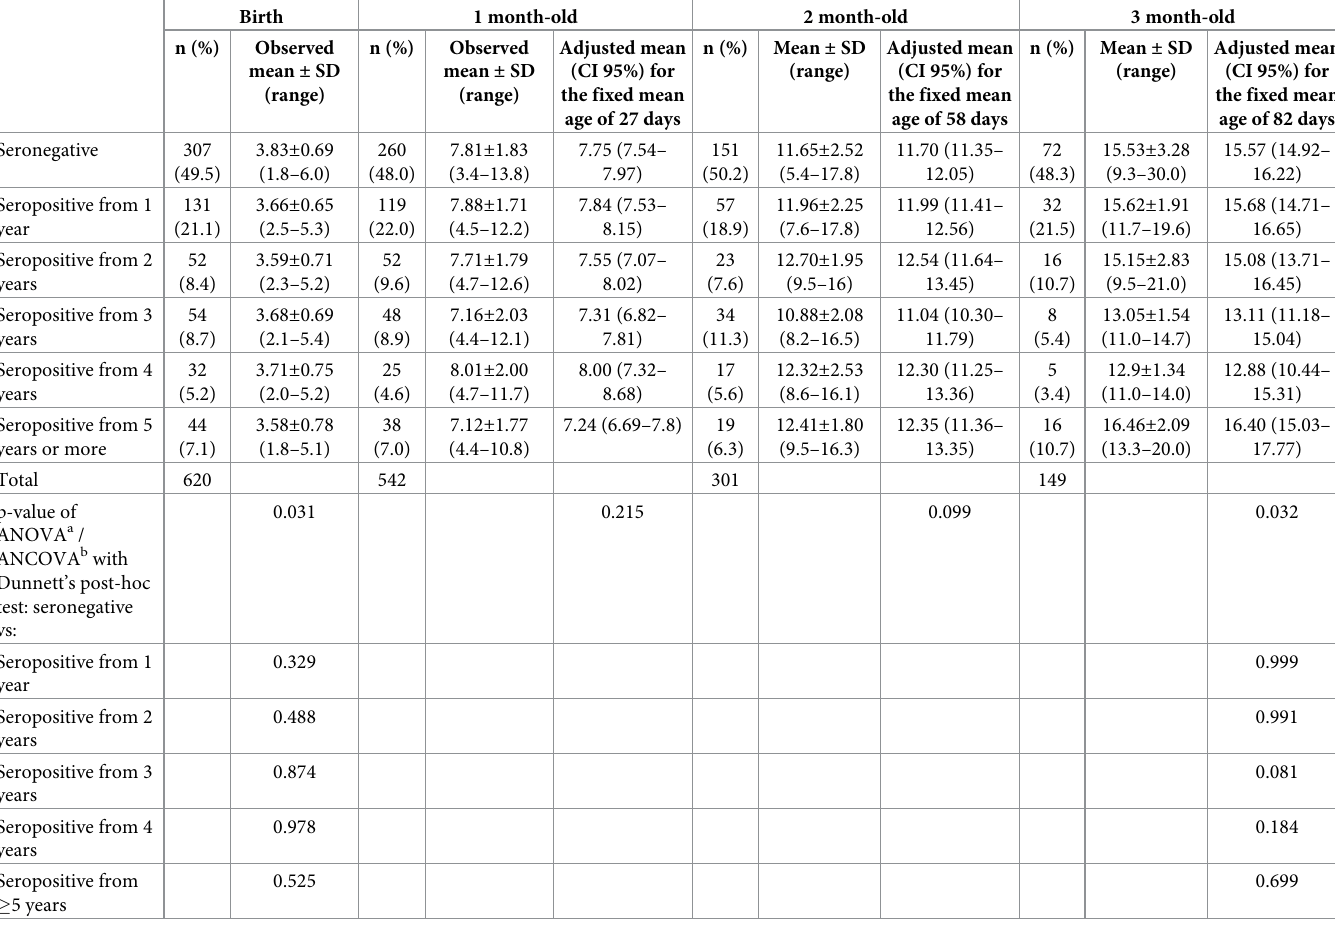
Table 3. Body weight of kids (BWT) born to does of different serological status in three different time points observed and adjusted by the exact age at which a kid was weighed. Birth 1